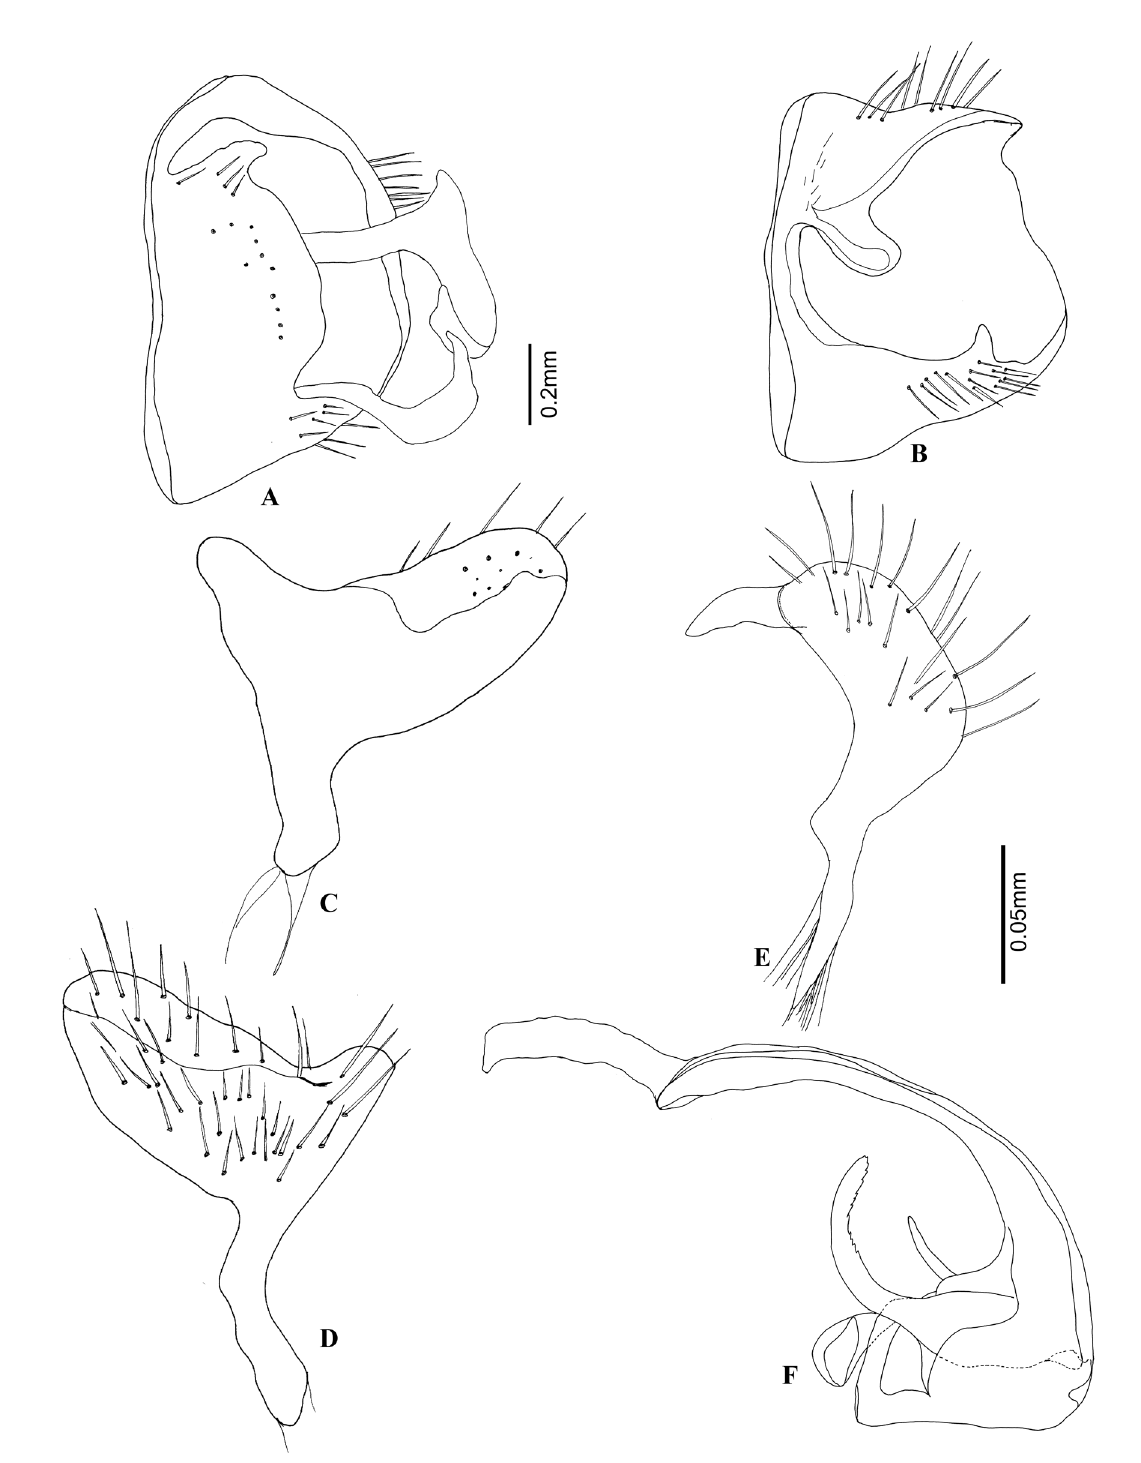
Fig. 21. Male genitalia of Namyatovia castlerockensis gen. et sp. nov., paratype, UASB. A–B . Genital capsule in dorsal and right lateral views. C–D . Right paramere in dorsal and ventral views. E . Left paramere in dorsal view. F . Aedeagus lateral